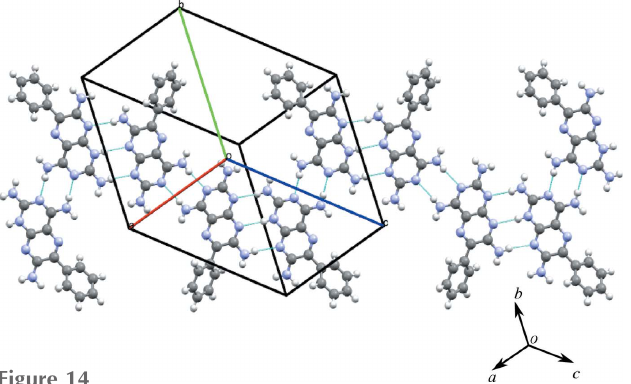
Figure 14 The crinkled tape of molecules of 1 observed in the crystal structure of 1g (cid:3) DMSO.